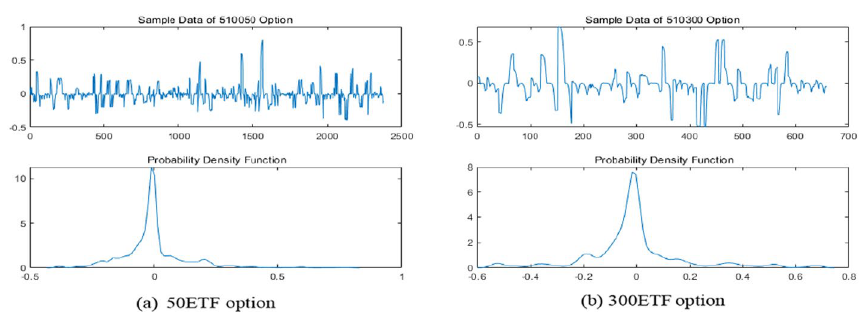
Fig. 3 The probability density distribution of 50ETF and 300ETF option with one month hold to